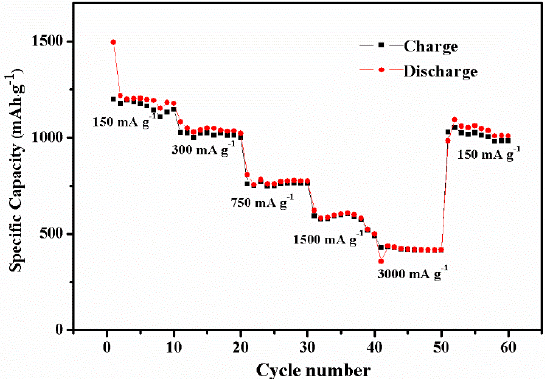
Figure 9. Rate capability of the silicon-carbon nanocomposite at different current densities between 0.01 and 1.5